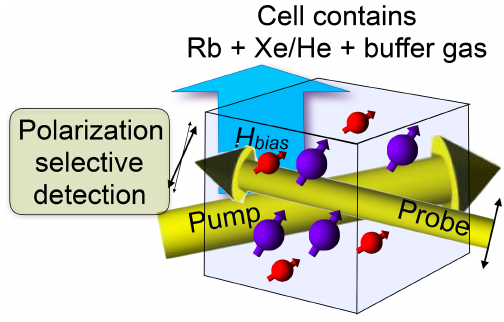
Figure 13. Setup for zero- and low-field NMR in an optical mag- netometer based on alkali atomic